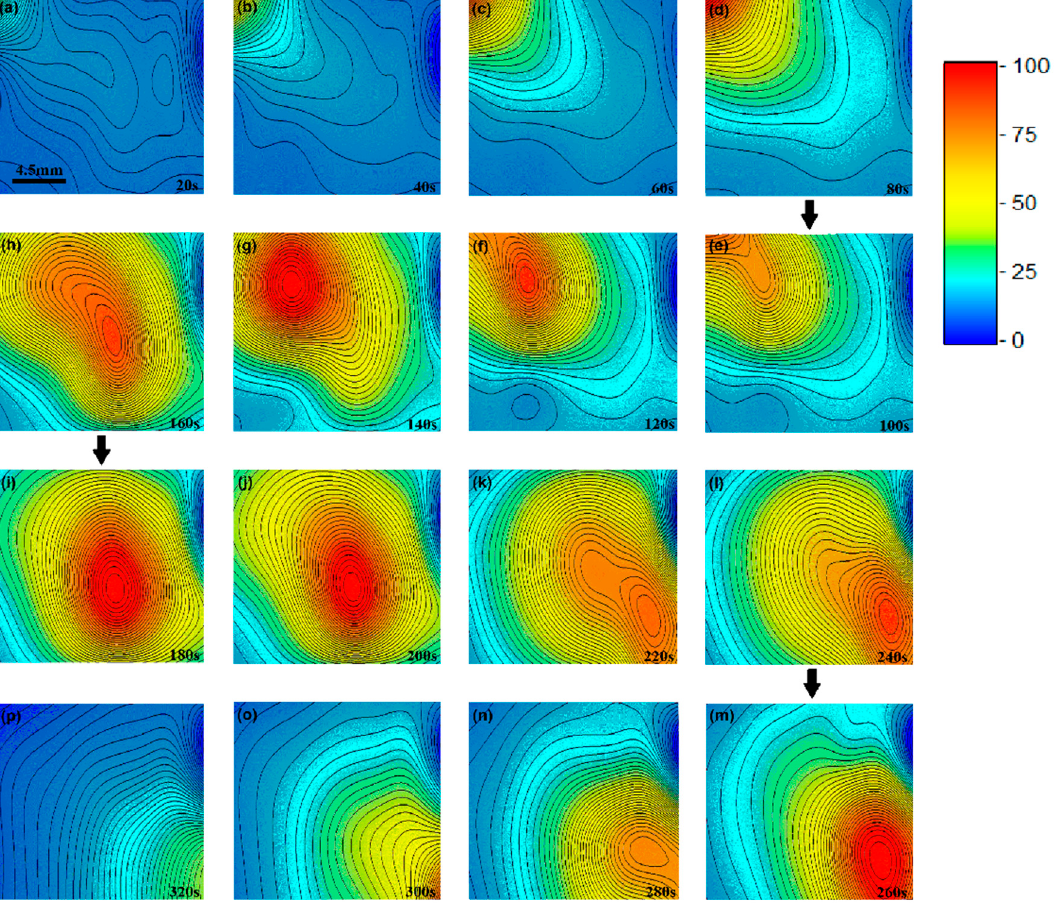
Figure 3. Experimental results taken from a continuous real-time mapping of 2D distribution of a sample. ( a – d ) Data for first 80 s, when a heater tip is moved from far away to the top-left corner, staying there for 80 s; ( e – p ) Data for the next 240 s, when the heater tip moves gradually from the top-left corner to the bottom-right corner. The movie of this process is available in the Supplementary Materials.